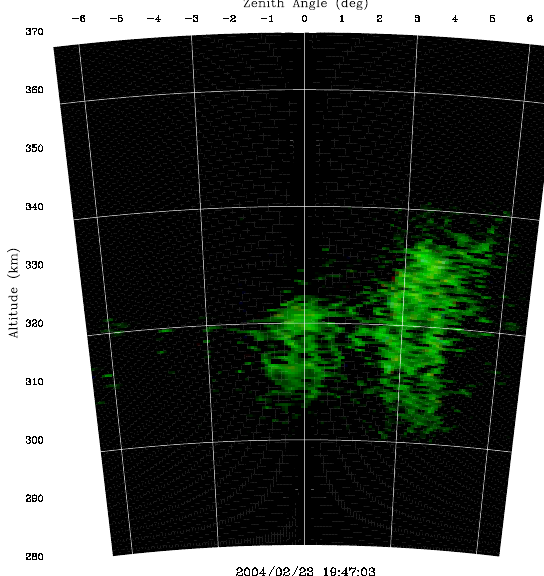
Fig. 3. Radar image of plasma irregularities within the bottom-type layer seen in the previous figure. The irregularities are shown at the moment they first drifted westward into the radar illuminated